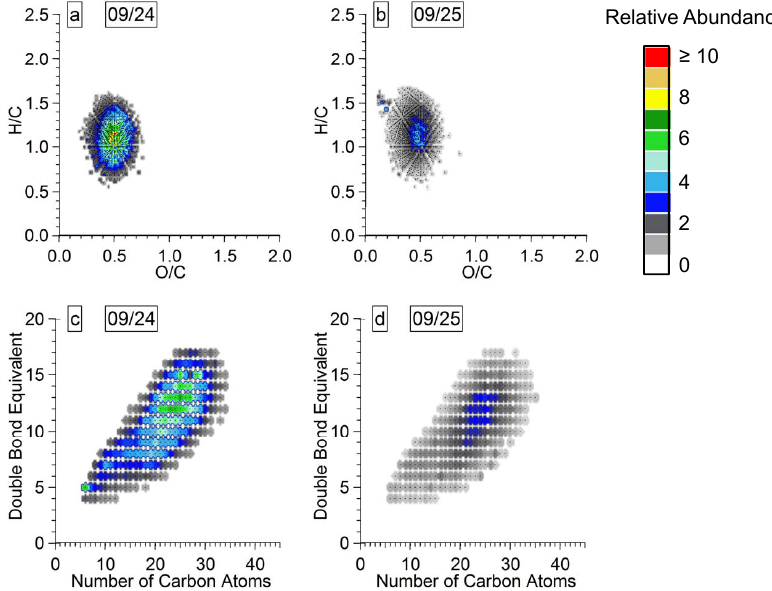
Figure 8. CHNO isoabundance van Krevelen diagrams of 9 / 24 (a) and 9 / 25 (b) with all detected individual ions shown as dots to facilitate visualization of CH 2 homologous series. Also shown are the double bond equivalents vs. the number of carbon atoms of the 9 / 24 (c) and 9 / 25 (d) for the CHNO group with symbol colour representing the relative